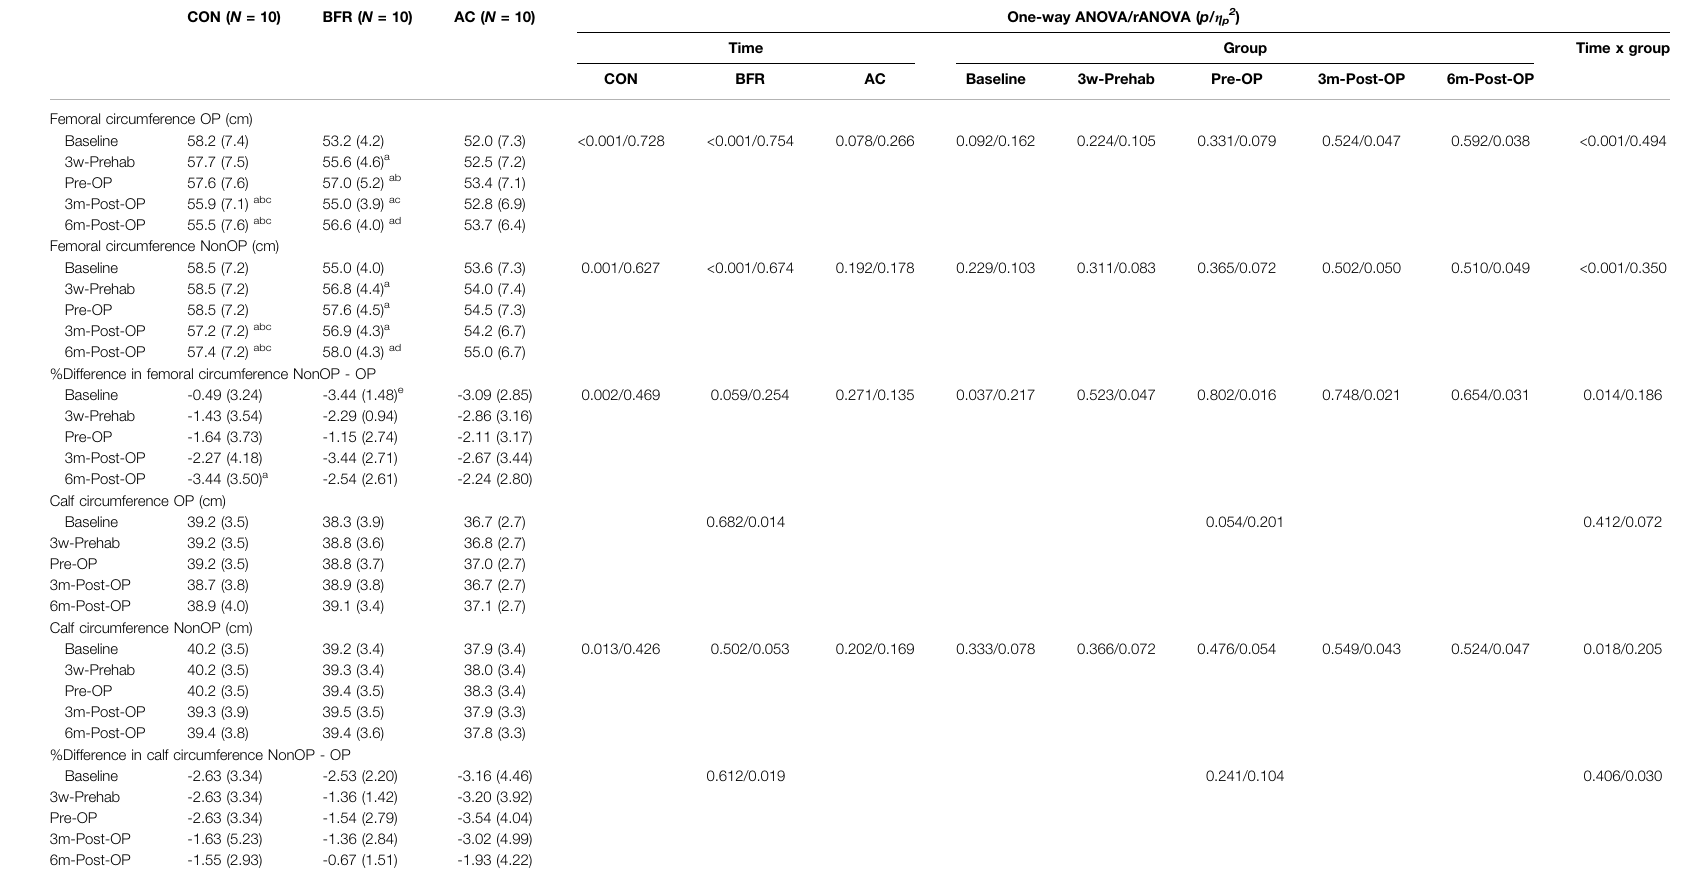
TABLE 3 | Measures related to skeletal muscle mass of the lower extremities during the prehabilitation- and post-operative period. CON ( N = 10) BFR ( N = 10) AC ( N = 10) One-way ANOVA/rANOVA ( p/ η p2 ) og y Time Group Time x group CON BFR AC Baseline 3w-Prehab Pre-OP 3m-Post-OP 6m-Post-OP Femoral circumference OP (cm) Baseline